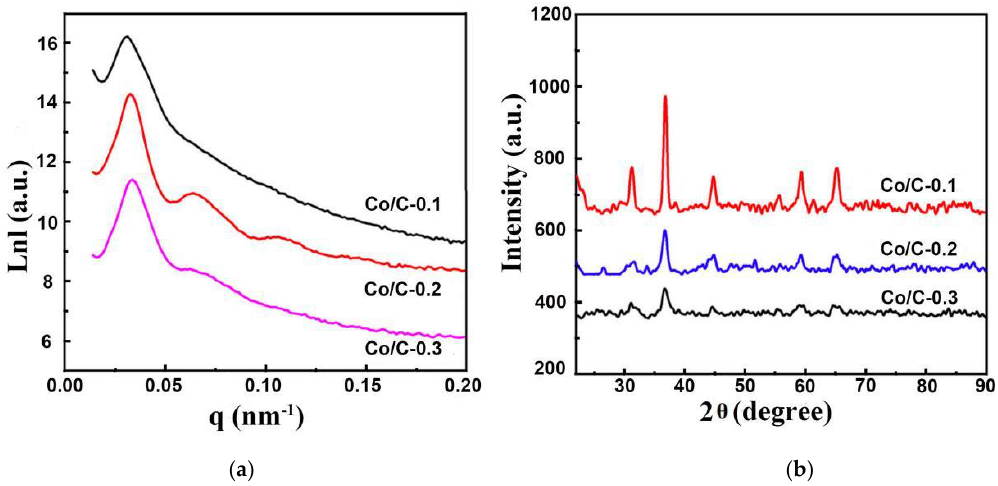
Figure 2. ( a ) SAXS patterns and ( b ) XRD measurements of the nanocomposites with different ratios of cobalt precursor/resol treated under N 2 atmosphere at 600 °C: CoO x /C-0.1, CoO x /C-0.2, CoO x /C-0.3.